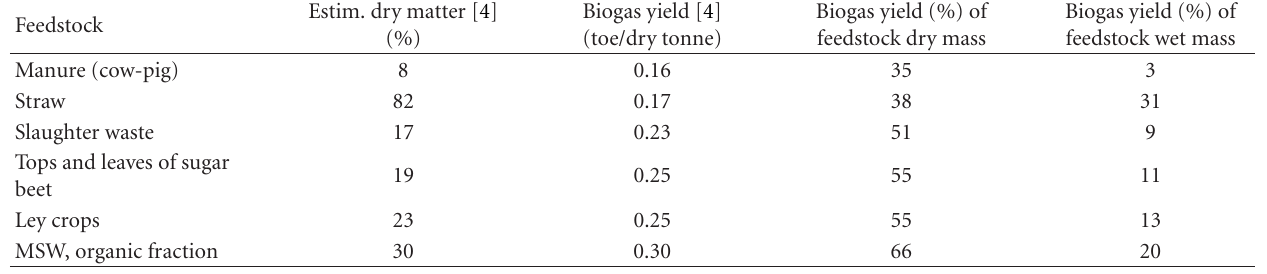
Table 2: Biogas yields from some feedstocks (toe: tonnes of oil equivalent − 1 toe = 42GJ).